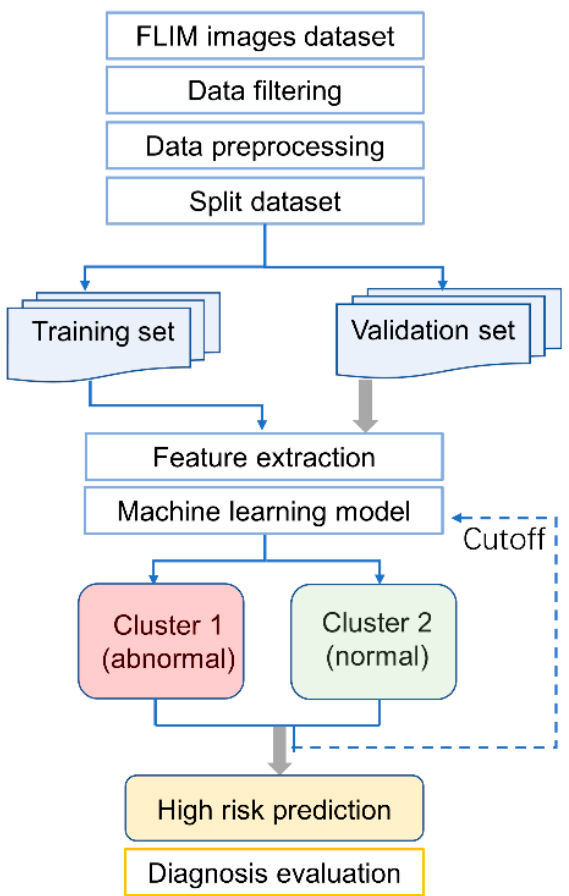
Figure 3. Flow chart of the FLIM-ML model for the prediction of high risk of cervical cancer.